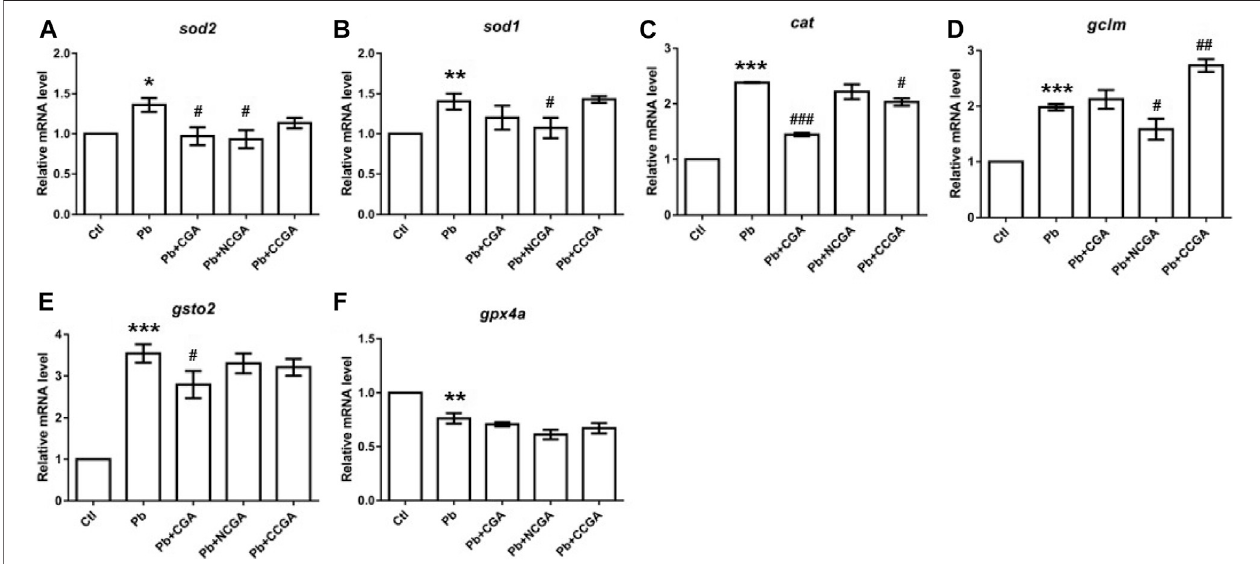
FIGURE8| Transcriptionofgenesrelatedtooxidativestress.ThegraphplotisrepresentedasfoldchangesinthemRNAexpressionofsod2 (A) ,sod1 (B) ,cat (C) , gclm (D) , gsto2 (E) , and gpx4a (F) . Data were represented as mean ± SEM, n (cid:1) 3, and statistically analyzed by one-way ANOVA followed by Dunnett ’ s multiple comparison test. * p < 0.05, ** p < 0.01, *** p < 0.001 vs. control and # p < 0.05, ## p < 0.01, ### p < 0.001 vs. Pb.